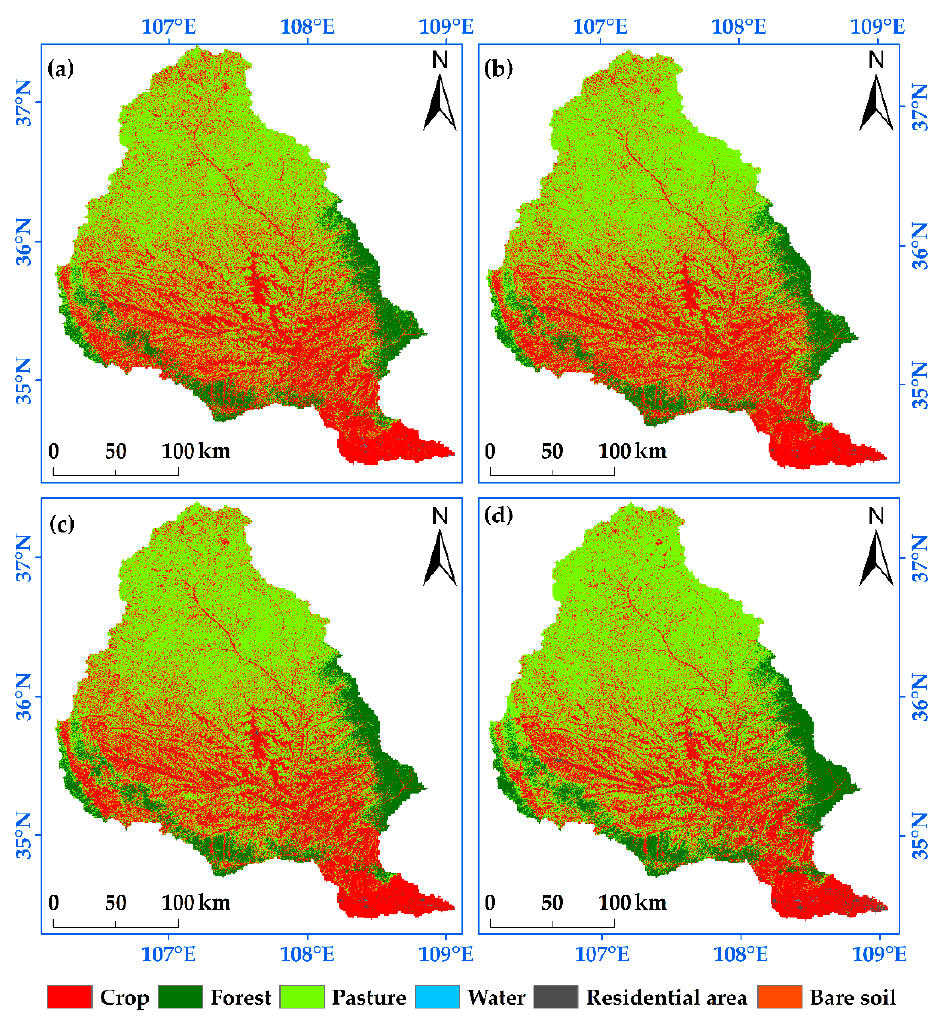
Figure 8. Land use in the human activity interference periods of the study;( a ) land use in 1985; ( b ) land use in 1991; ( c ) land use in 1999; ( d ) land use in 2013.